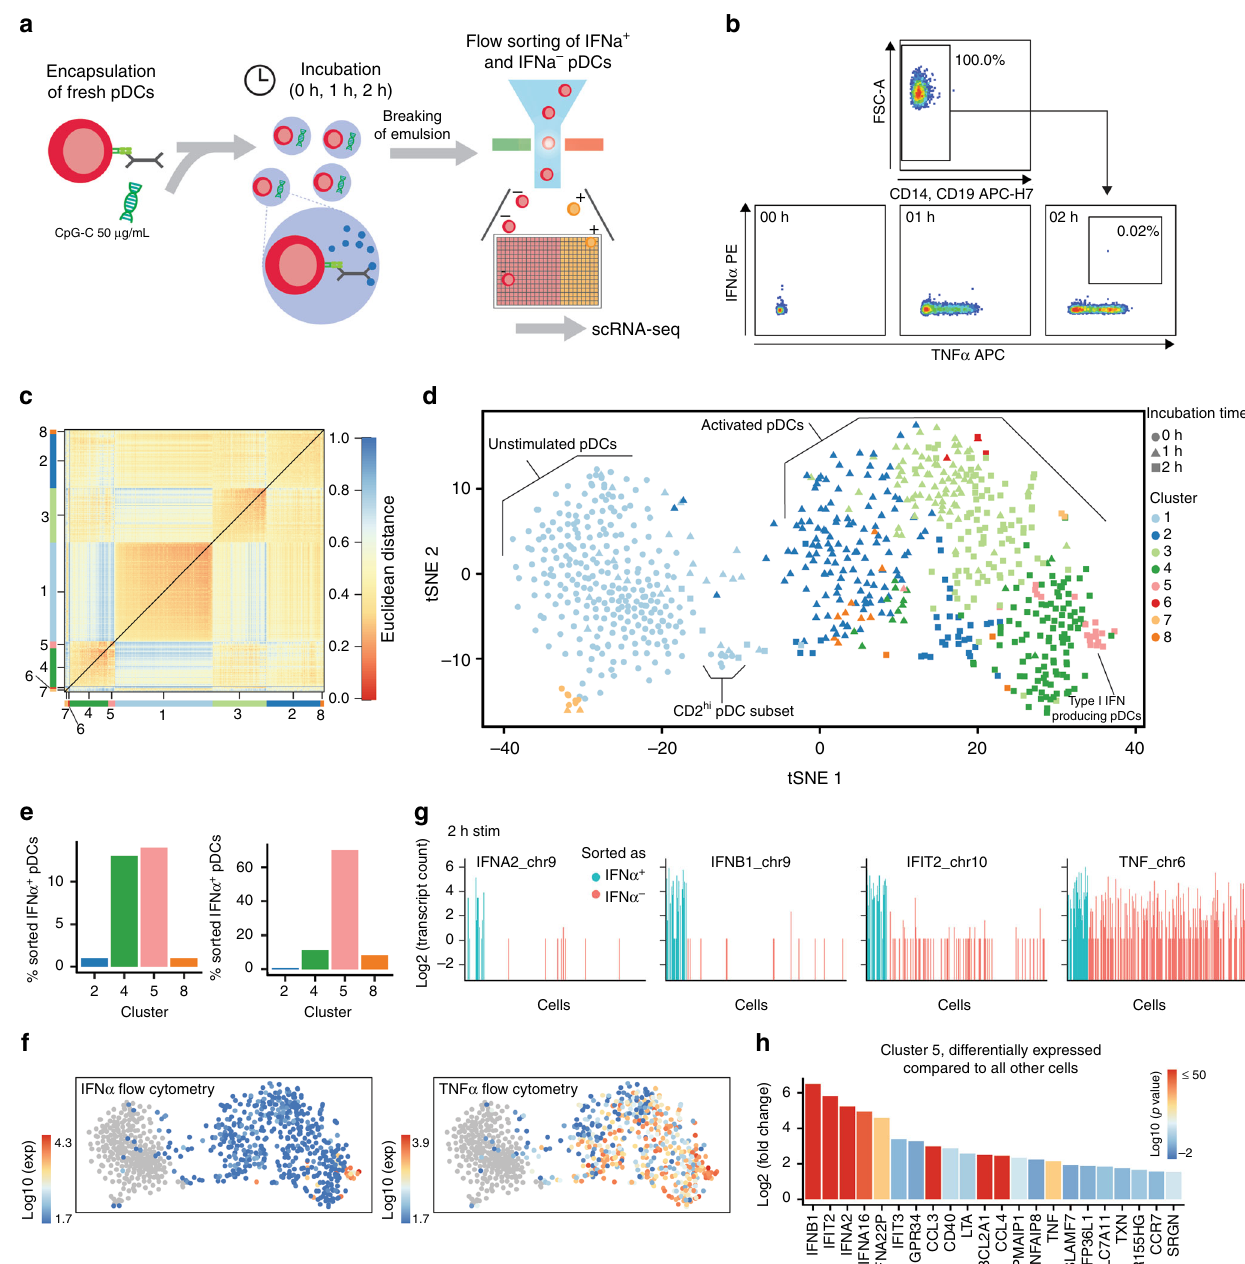
Fig. 3 Single-cell RNA-sequencing identi fi es type I IFN-expressing cells early after activation. a The pDCs were coated with capture reagent, encapsulated in picoliter droplets, and stimulated individually with 50 µ g/mL CpG-C for varying amounts of time. b After staining for surface marker expression and cytokine secretion, different pDC subsets were collected using fl uorescence-activated cell sorting (FACS) and their transcriptomes were sequenced using the SORT-Seq protocol. c Heat map of the 774 cells that passed quality control fi lters representing transcriptome similarities as measured by Euclidean distance. The k -medoid clustering in combination with the raceID2 algorithm identi fi ed 8 distinct cell clusters. d t-SNE map showing all identi fi ed clusters. Different colors indicate clusters, different shapes indicate stimulation time. e The employed work fl ow allowed to link protein expression data acquired during FACS to the transcriptome data. The number of IFN α + cells assigned to each cluster, and the percentage of sorted IFN α + cells in each cluster, is plotted against the cluster name. f t-SNE map showing the fl uorescence intensity of IFN α and TNF α as measured during FACS for each cell. g Shown are transcript counts for genes of the type I IFN response and the TNF gene in single cells stimulated for 2 h with CpG-C. IFN α + cells, identi fi ed during FACS, are indicated in blue, other cells are shown in red. h Genes that were upregulated in cluster 5 compared to cells from all other clusters were detected ( p < 10 − 8 ). Shown is the log2(fold change) for each gene. The color scale indicates the corresponding p